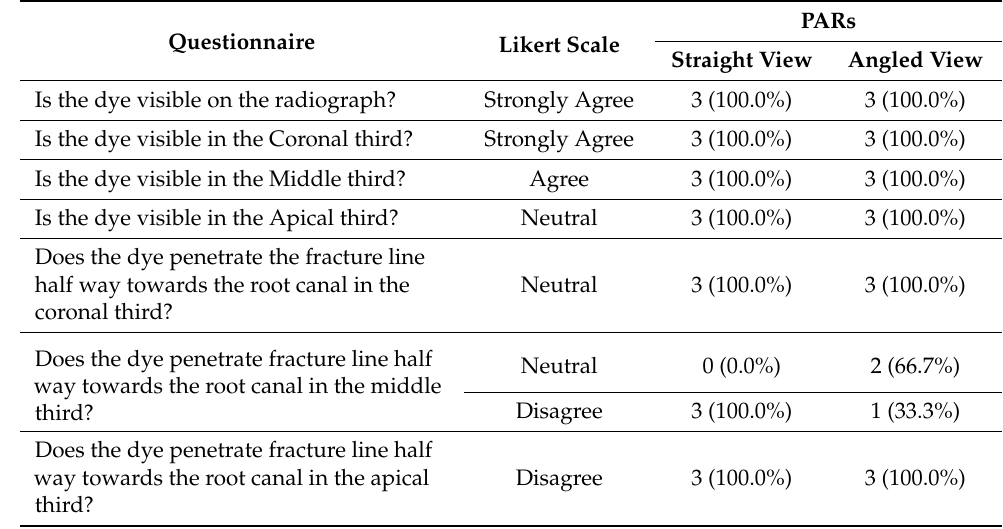
Table 2. Percentages of means of responses based on PARs for experimental group (n =